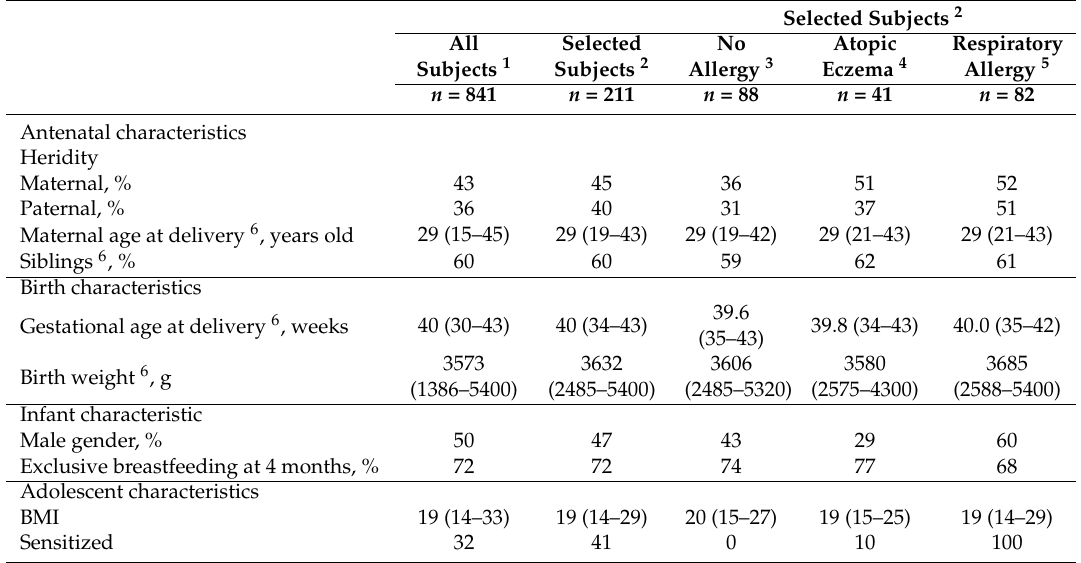
Table 1. Characteristics of the birth cohort and the study